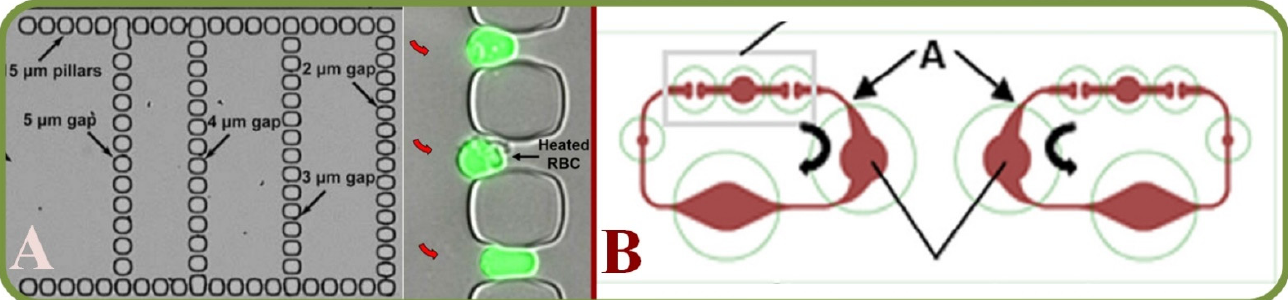
Figure 17. Organ-On-Chips and drug discovery involving single RBCs. ( А ) A biomimetic microfluidic chip to study the circulation and mechanical retention of RBCs in the spleen, including the top view of the fabricated filtration unit and the preferential retention of poorly deformable RBCs in slits [401]. ( B ) Chip-based human liver–intestine and liver–skin, including RBCs assisted ( B ) Chip-based human liver–intestine and liver–skin, including RBCs assisted microparticle imaging microparticle imaging velocimetry setup and fluid flow circuits [405]. velocimetry setup and fluid flow circuits